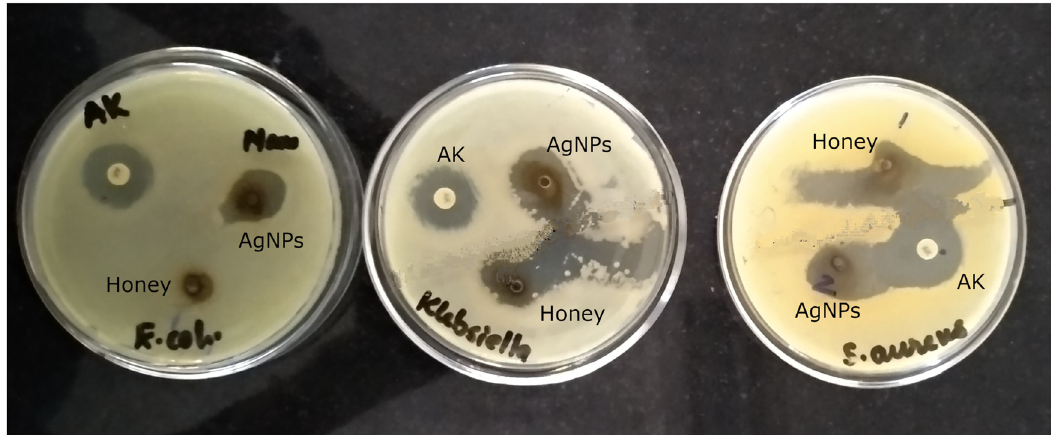
Figure 10: Zone of inhibition against E. coli , Klebsiella , and S. aureus .